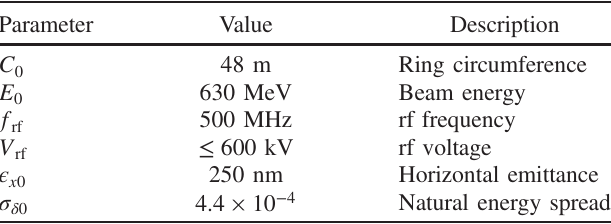
TABLE I. Parameters of the MLS in the